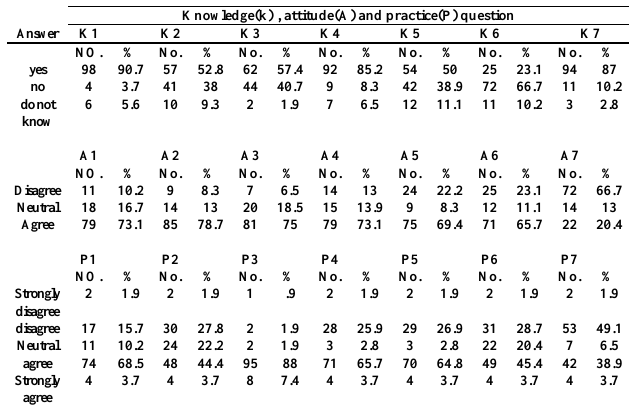
Table 2 : frequency and percentages of participant`s responses to the knowledge, attitude, and practice questions